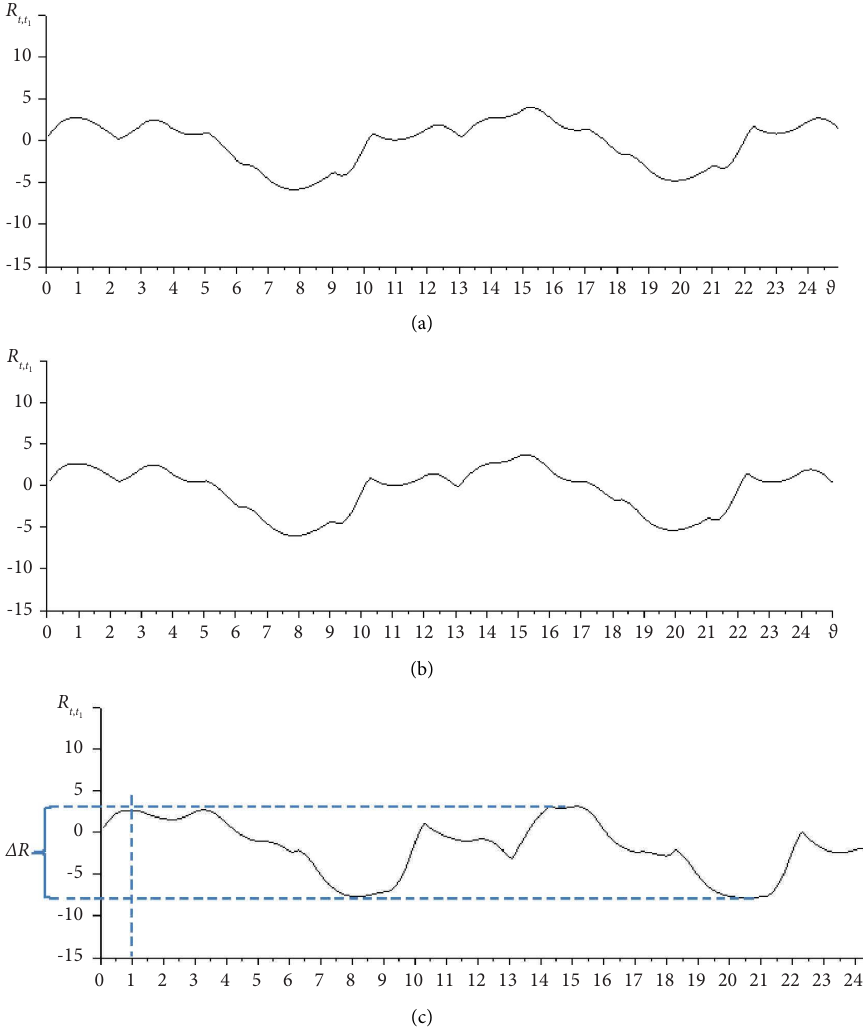
Figure 6: Results of simulation of the process of parameter